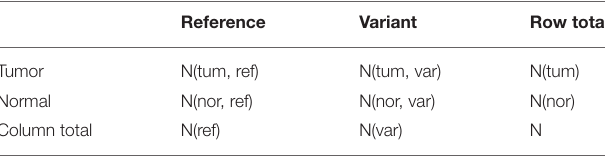
TABLE 3 | The 2 × 2 contingency table for computing the p -value using Fisher exact test. Reads supporting